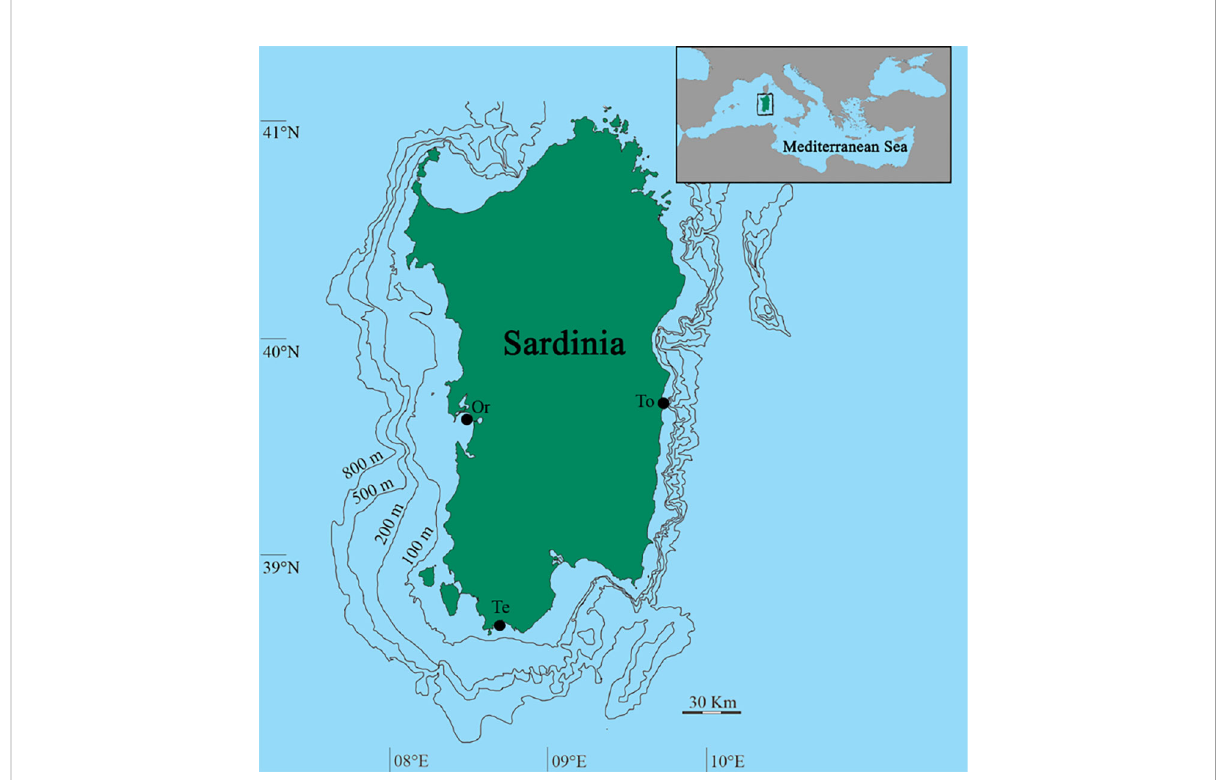
FIGURE 1 Map of the study area. Sampled sites of Oristano (Or), Teulada (Te), and Tortolì (To) are